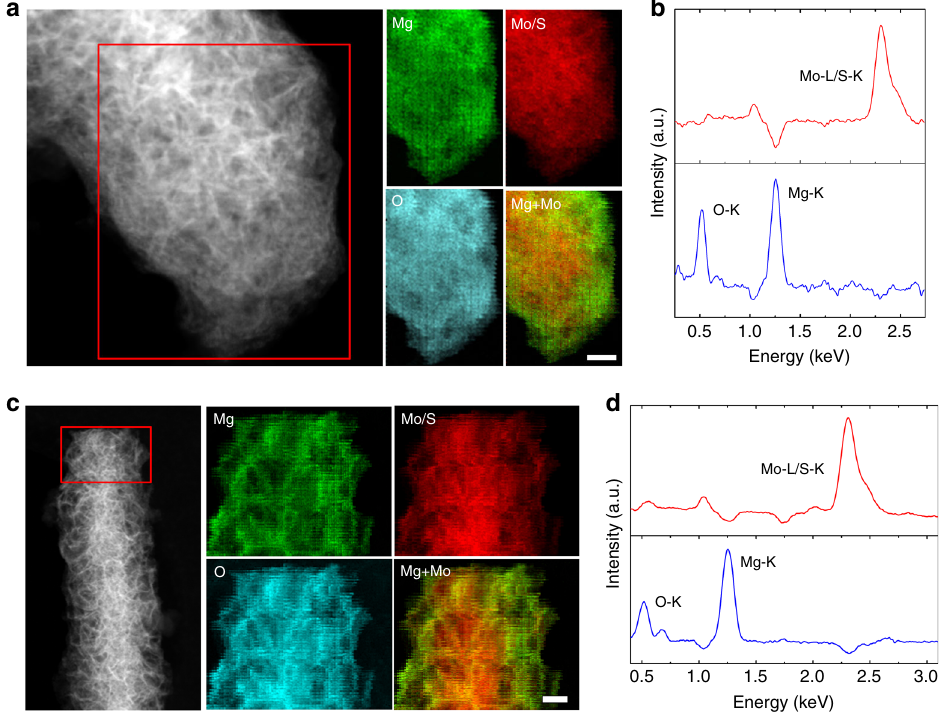
Fig. 5 EDX mapping and PCA. STEM-HAADF image and the corresponding EDX maps of MoS 2 @C-PNR electrodes at a 30th discharged state and c 10th discharged state taken from the area highlighted by red box in the corresponding STEM-HAADF image. The scale bars of element maps correspond to 50 nm. PCA components of the EDX spectral image of samples at b 30th discharge state and d 10th discharged